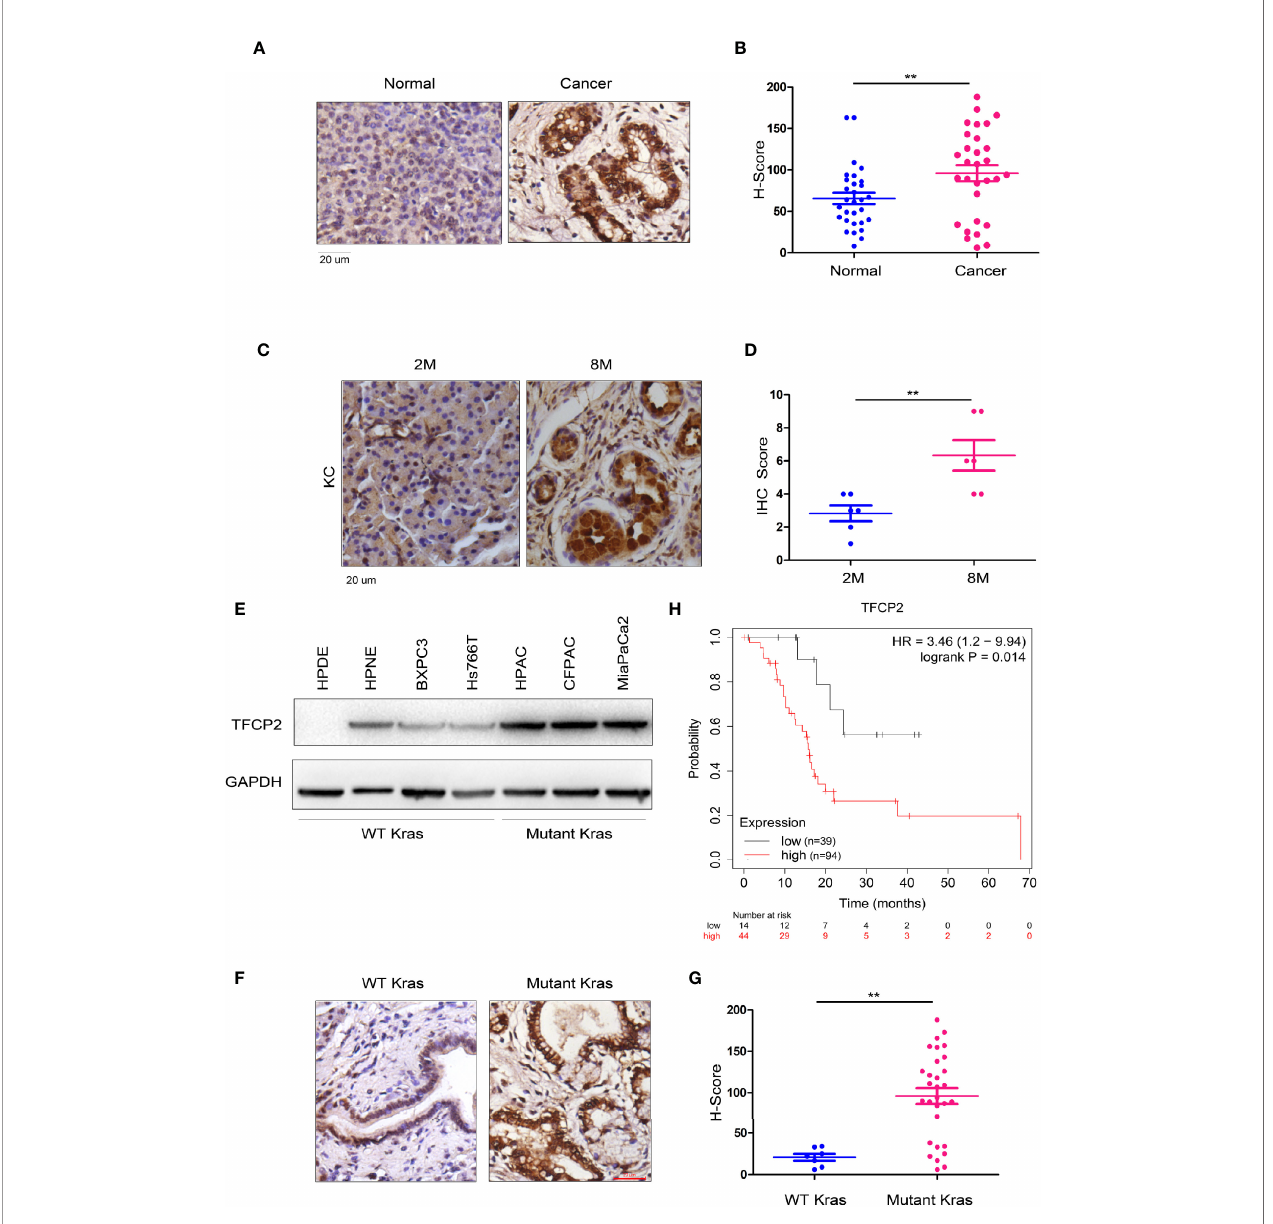
FIGURE 1 | TFCP 2 was up-regulated in the progression of pancreatic cancer. (A) IHC was performed to examine the protein levels of TFCP2 in the clinical samples of pancreatic cancer and non-cancerous tissues (N = 32). (B) Statistical analysis was performed for (A) . (C) IHC was performed to examine the protein levels of TFCP2 in pancreatic tissues of KC mice with indicated age. (D) Statistical analysis was performed for (C) . (E) The protein levels of TFCP 2 in the normal pancreatic cell line (HPDE6C7 and HPNE) and cancer cell lines were examined using western blot. (F, G) IHC was performed to examine the protein levels of TFCP2 in the clinical samples of pancreatic cancer with (n = 25) or without (n = 7) Kras mutation (21 samples harboring G12D mutation, 1 samples harboring G12C mutation, 3 samples harboring G12V mutation), then the staining was scored and analyzed. (H) The survival analysis through mining the Kaplan-Meier Plot database ** P <